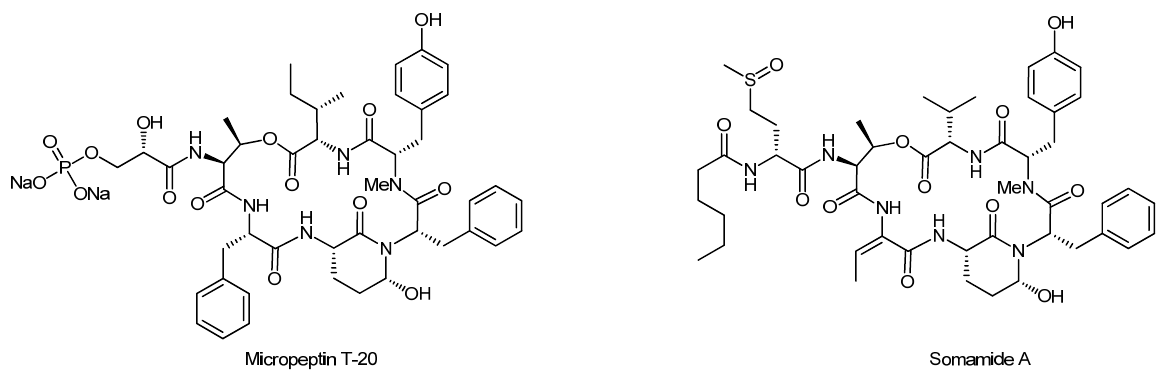
Figure 4. Micropeptin T-20 [63] and somamide A